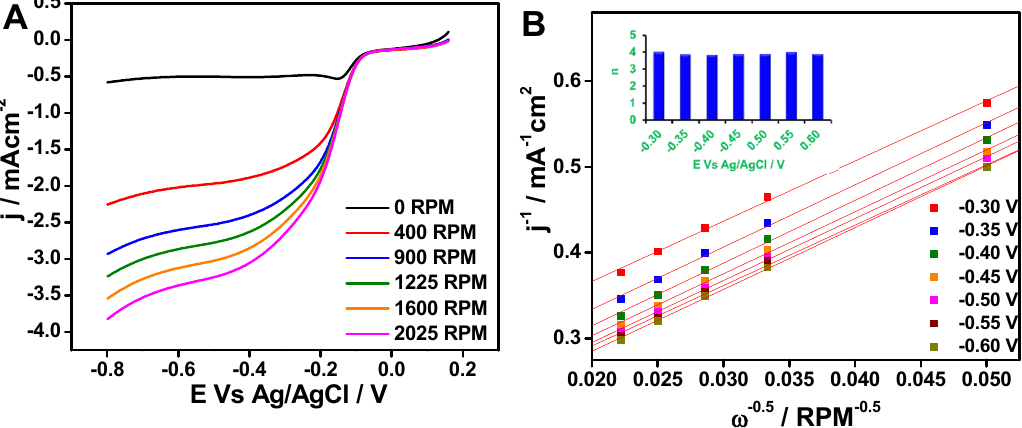
Figure 8. ( A ) Linear sweep voltammogram carried out in 0.1 M KOH at a scan rate of 5.0 mV s − 1 with different rotating speeds using a rotating disc electrode modified with N-IC-rGO. ( B ) Koutecky–Levich (K-L) plots constructed using rotating disc linear sweep voltammograms (insert: number of electrons transferred at different potentials determined from K-L plots).